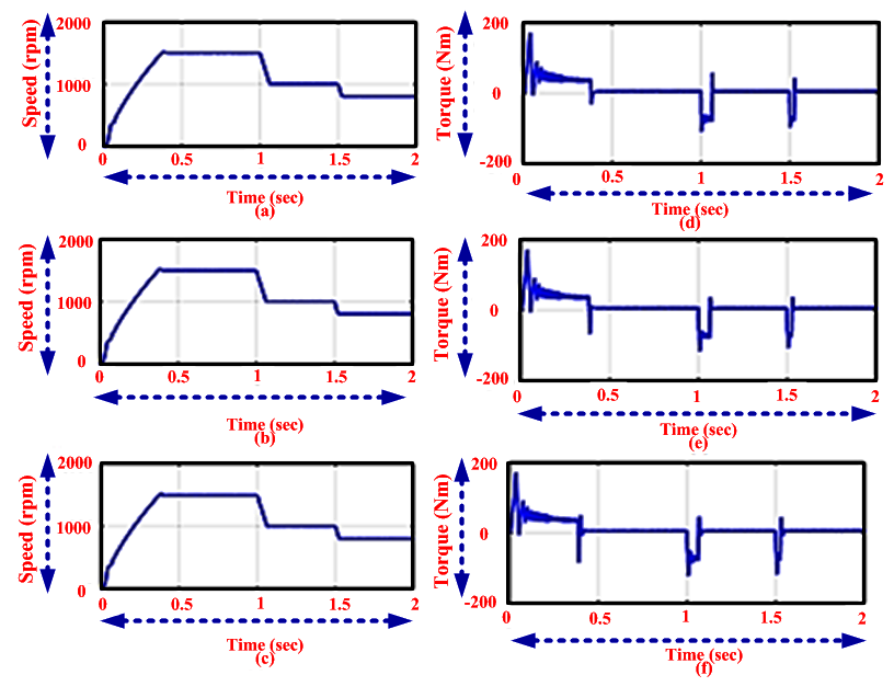
Figure 8. Analysis of Speed using the ( a ) proposed, ( b ) MFO method, and ( c ) PI controller and Torque using the ( d ) proposed, ( e ) MFO method, and ( f ) PI controller.